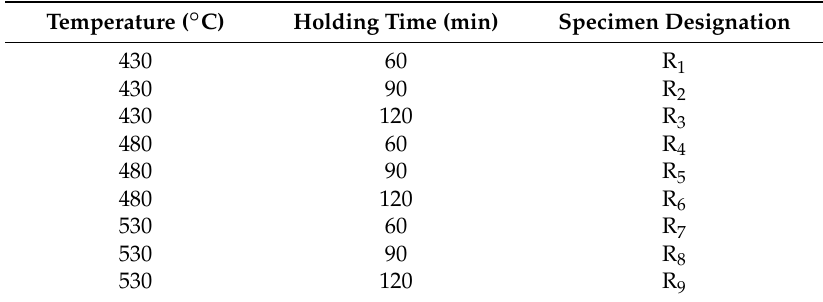
Table 3. Specimen designation at different operating temperatures and holding times